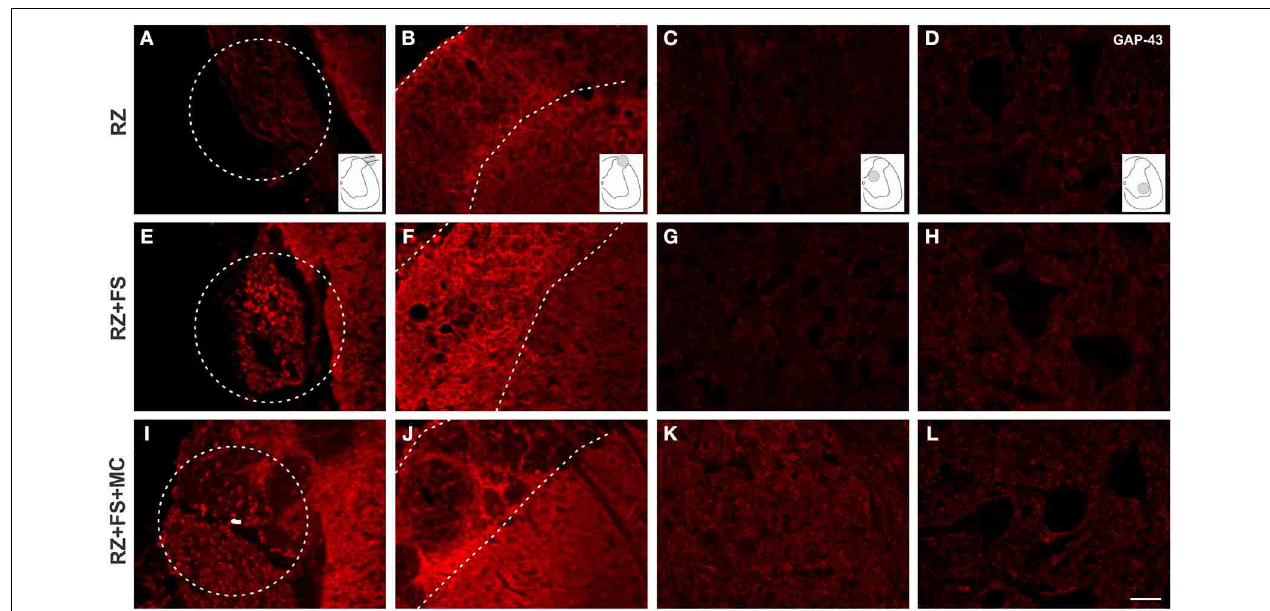
FIGURE 11 | Immunohistochemistry for GAP-43. (A–L) Representative images of RZ, RZ + FS and RZ + FS + MC, 4 weeks post lesion. The location at the dorsal root area (dashed circles) and within the spinal cord (dashed lines) is indicated by the schematic drawings. Observe the